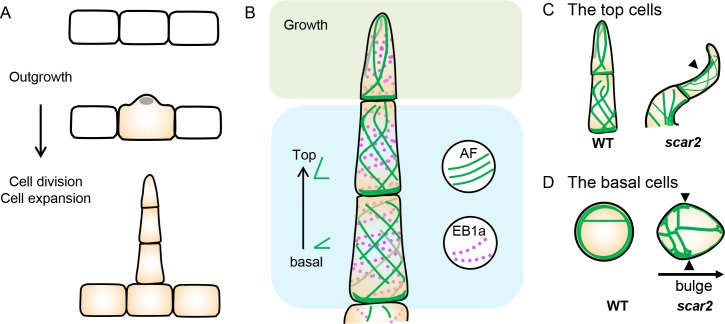
Schematic illustration of the role of actin filaments (AFs) and micro tubules (MTs) in multicellular trichome development.(A) The morphogenesis of the multicellular trichomes. The first step is the outgrowth of the cell. At this stage, the nucleus enters into the bulging site. The second step is the cell division and cell expansion. The grey oval shows the nucleus. (B) The organization of Liftact decorated AFs and EB1 decorated MTs during trichome cell morphogenesis. The green lines show the organization of Liftact decorated AFs. The red dots show the signal of EB1a. In the apical cell, the orientation of actin filaments is longitudinal which may promote the polar growth of the cell. In the middle and basal cells, actin filaments are spirally organized. The green angles mean that the alignment of AFs gradually changes from transverse and spiral to longitudinal in cells from the basal to the top. (C D) The organization of actin filaments in WT and dt-2 mutant. The mutation of SCAR2 leads to misshaped cells. (C) In the top bent cells, actin cables align longitudinally in WT while gathered on adaxial side of the cell (pointed by black triangle) in scar. (D) In the swollen cell in scar-2, aggregated actin bundles were often observed in the cortical region of the cell (black triangle), and thick actin cables in the cytoplasm was more frequent than WT.